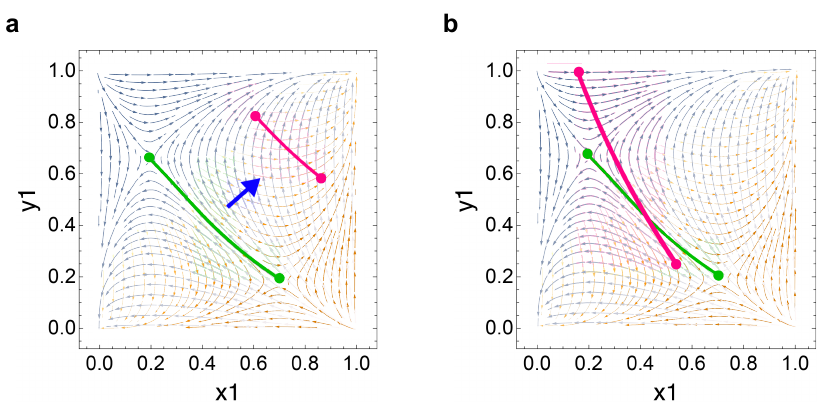
= 0; ( b ) attractor (cid:54)